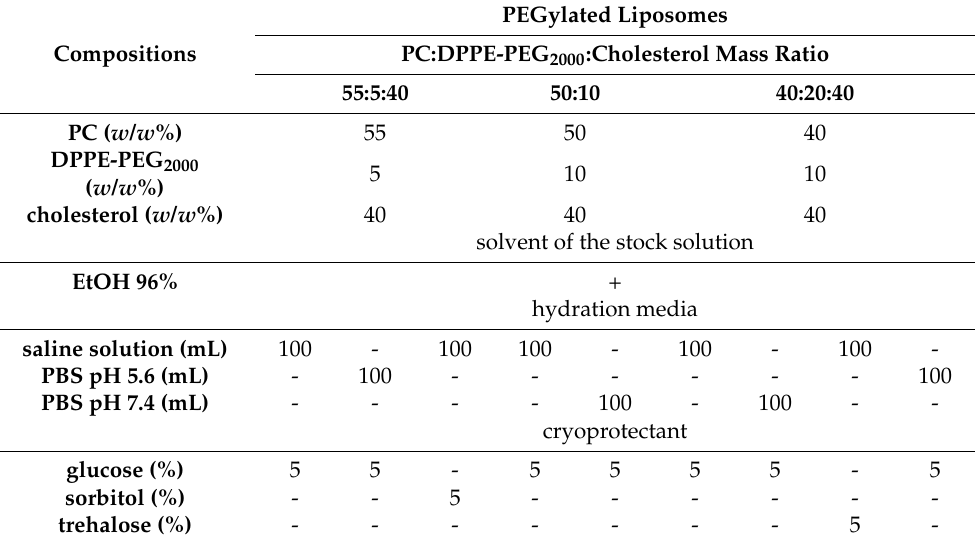
Table 2. Phosphatidylcholine, PEGylated phosphatidylethanolamine and cholesterol-based (PC-CH- PEG) compositions.